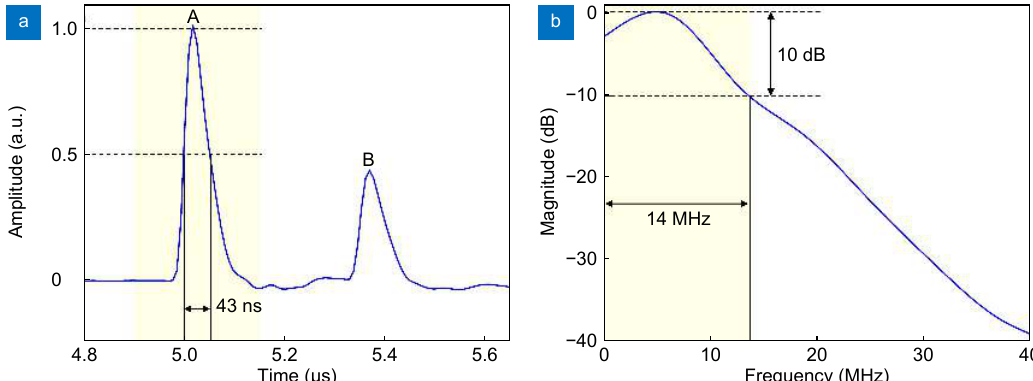
Fig. 4 | ( a ) Recorded signals in response to broadband ultrasound wave. ( b ) Measured frequency responses of the microfiber-based ultrasound sensor.